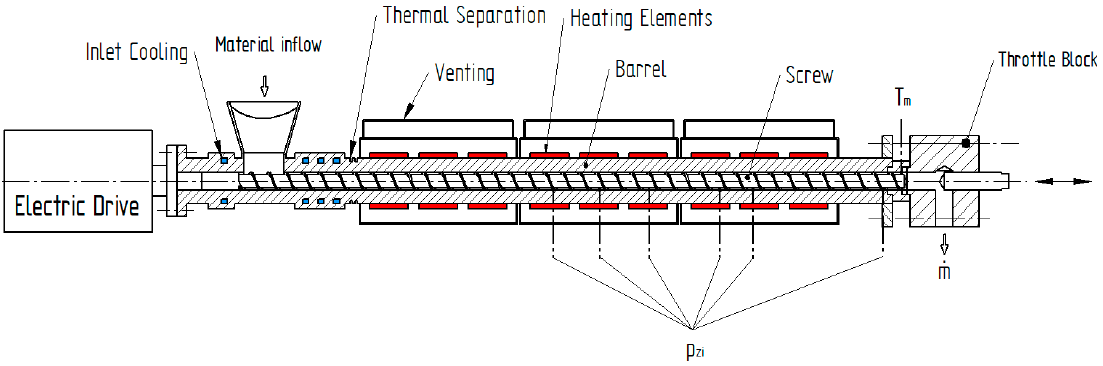
Figure 2. Schematic diagram of the 35 mm plasticating single-screw extruder.